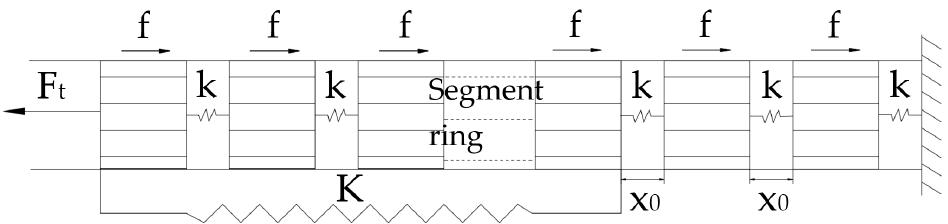
Figure 4. Schematic diagram of load model of thrust unloading segment lining under steel channel reinforcement.